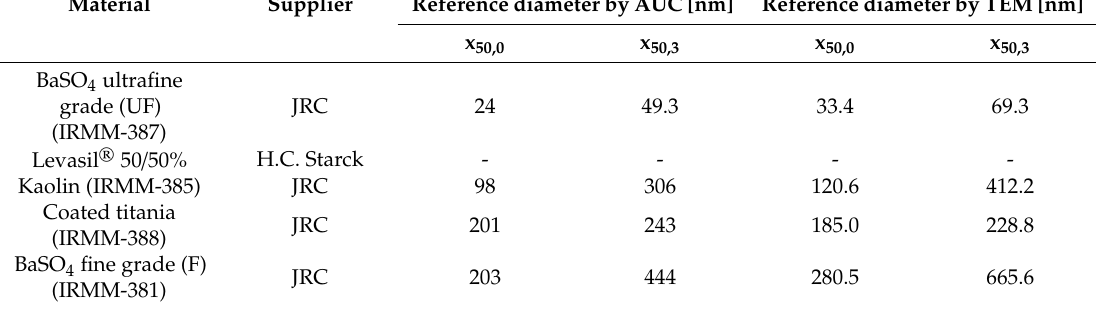
Table 1. Representative test materials (RTMs) used in this study. Reference diameters obtained by analytical ultracentrifuge (AUC) and transmission electron microscopy (TEM) were taken from the